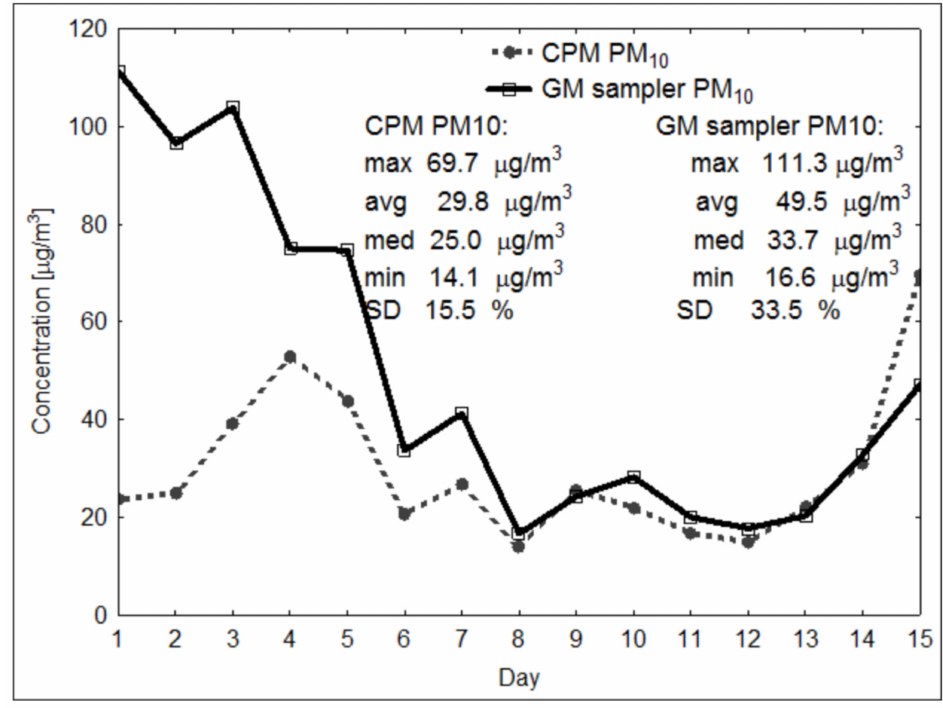
Figure 3. Average 24 h PM10 mass concentration obtained by two methods in spring